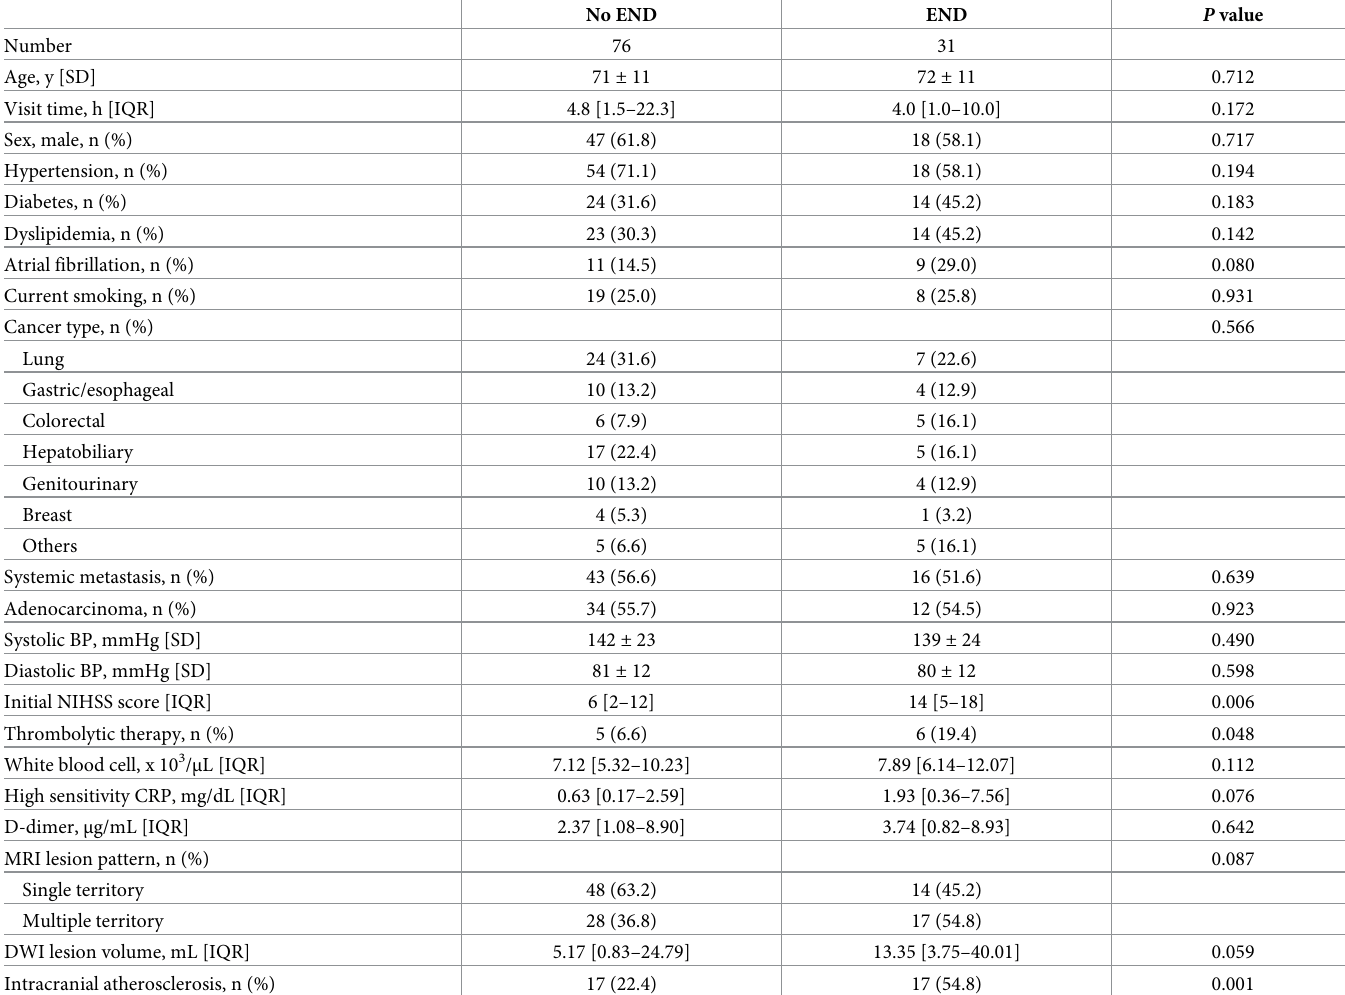
Table 1. Baseline characteristics of patients with and without early neurological deterioration (n =